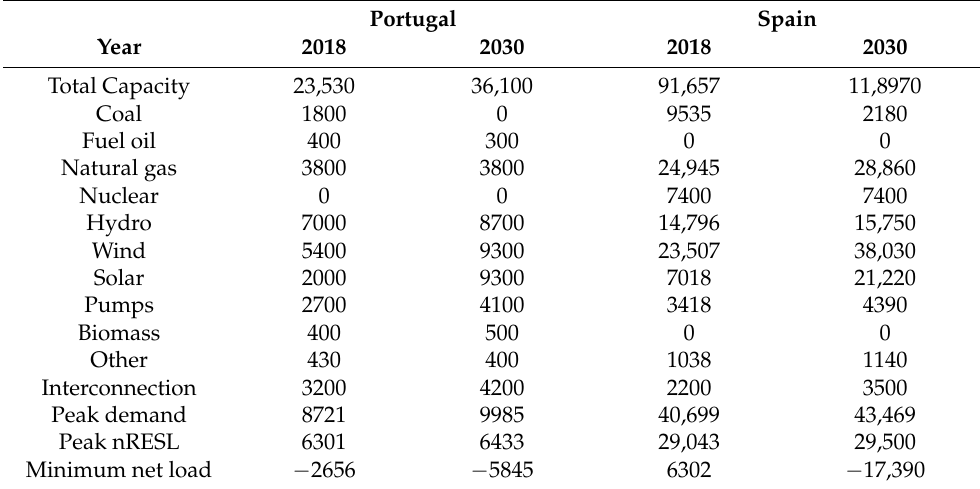
Table 1. Real (2018) and expected (2030) installed capacity in the Iberian Peninsula, the interconnec- tion capacity of each country, peak demand, and net load (all in MW).